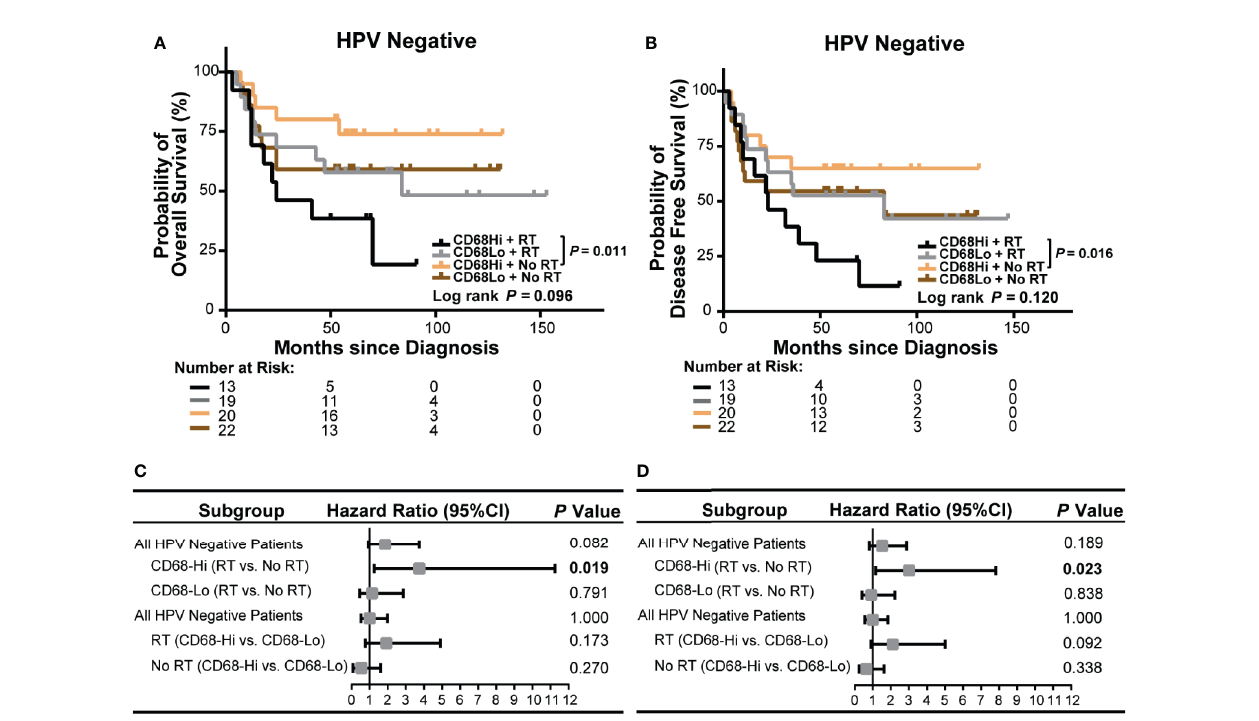
FIGURE 5 | Association of CD68 + macrophage in fi latration and radiation with survival of HPV negative OSCC patients in our cohort. (A, B) Kaplan-Meier curves exhibit overall survival (A) and disease-free survival (B) in high or low level of CD68 + macrophage in fi ltrated HPV negative OSCC patients receiving radiation or no radiation. Log-rank test and/or pair wised comparison was used for signi fi cance. (C, D) Forest plots illustrate hazard ratios of subgroup univariate cox regression of overall survival (C) and disease-free survival (D) . CD68-Hi, CD68-High; CD68-Lo, CD68-Low; RT,